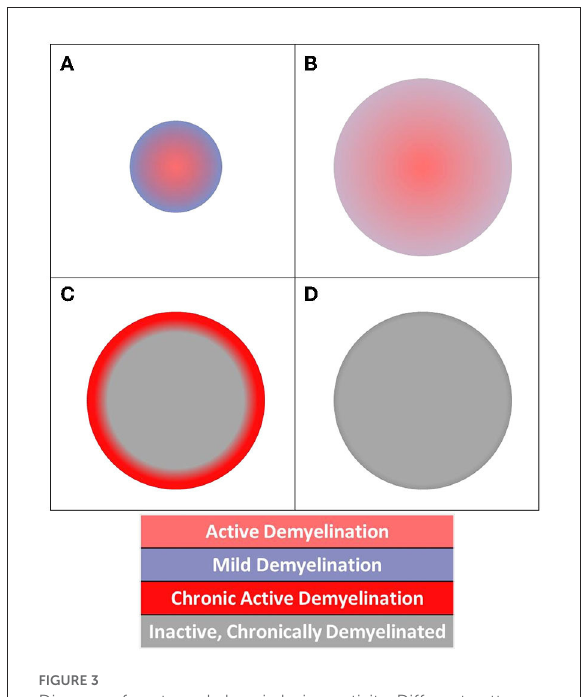
FIGURE3 Diagram of acute and chronic lesion activity. Different patterns of pathology are visible in (A) acute lesion, (B) slowly expanding lesion, (C) chronic active lesion, and (D) chronic inactive lesion